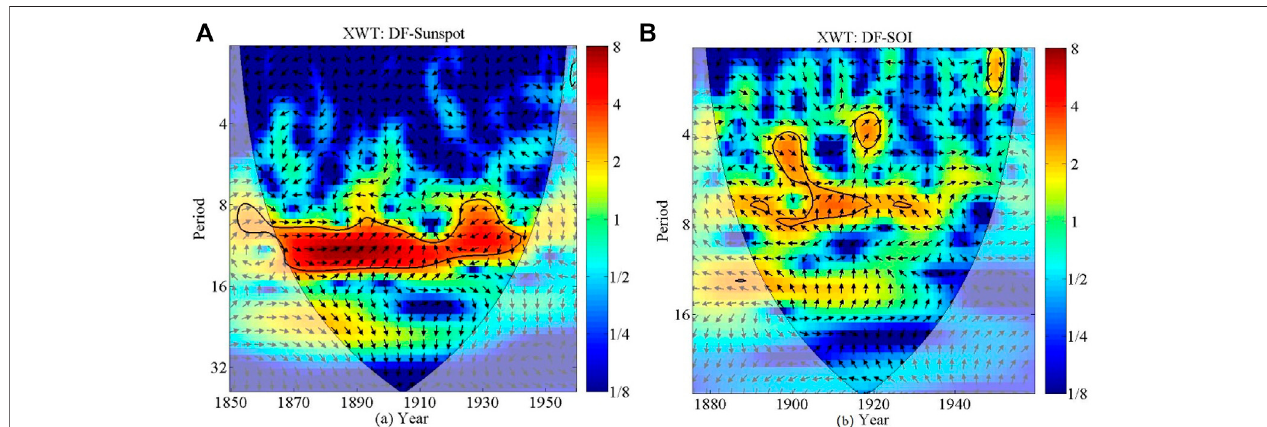
FIGURE8| Cross wavelet power betweenDFand sunspotand betweenDFand SOIinthe QinlingMountains(Note: Theclosed areaofthesolid black circle isthe standardbackgroundspectrumtestwitha95%con fi dencelevel;arrowsindicatethephaserelationship, ← indicatesanegativecorrelationbetweentwoserieschanges, → indicatespositivecorrelation; ↑ indicatesdroughtand fl oodsequencechangelagsthesunspotchangephaseby90 ° , ↓ indicatesdroughtand fl oodsequencechange phase ahead of the sunspot by 90 ° ; DF denotes drought and fl ood sequence; XWT: Cross wavelet